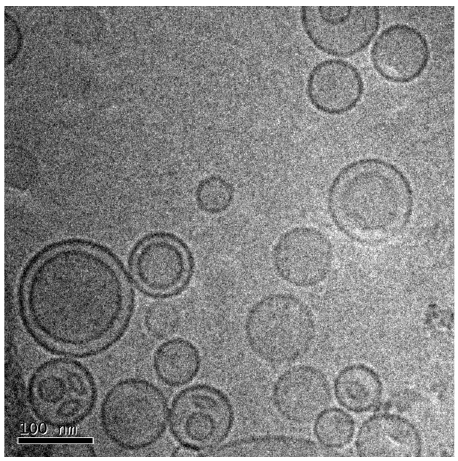
Figure 4: Image taken by TEM from Nio - GGE. This image shows clearly two - layer structure of niosome and its spherical